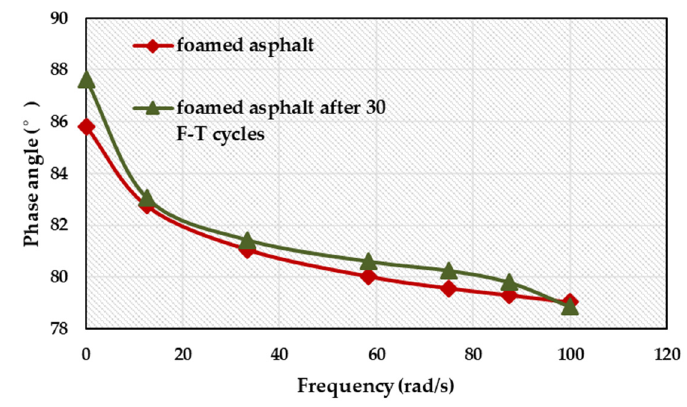
Figure 10. Phase angle of foamed asphalt and foamed asphalt with 30 F–T cycles